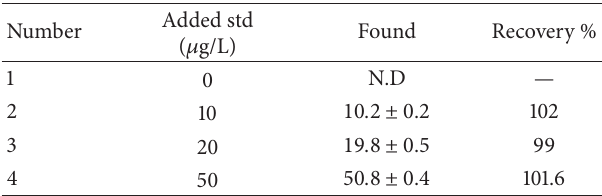
Figure 3: Effect of sample injection volume on the recovery of arsenic; condition: elution flow rate: 5mL/min and pH = 6.